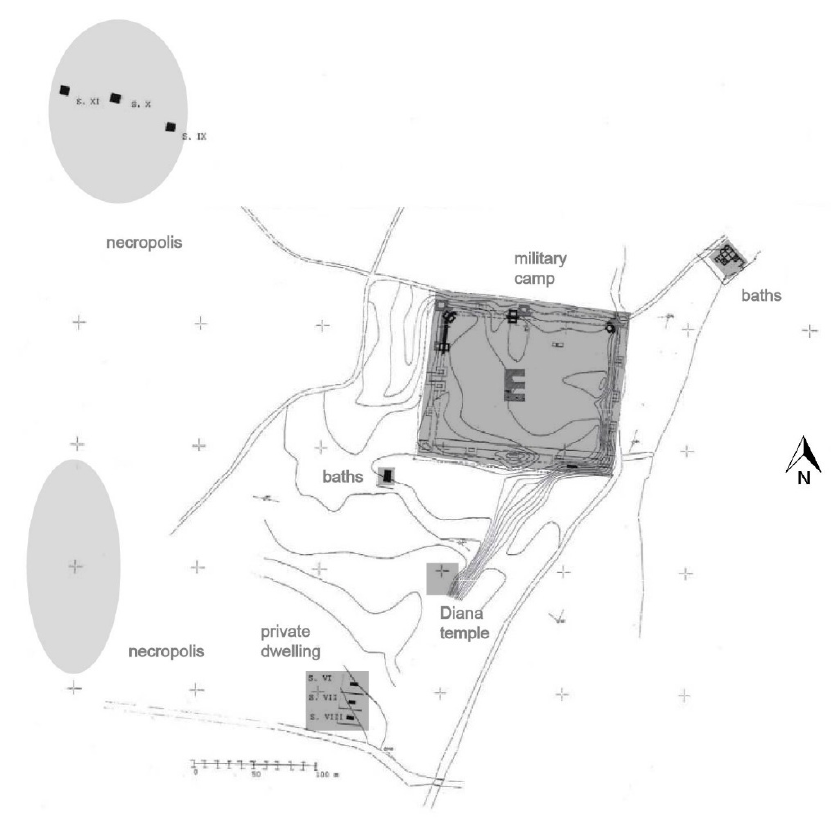
Figure 3. Overview of Timacum Minus (adapted from Petkovi ć and Iliji ć , 2012, [43]).